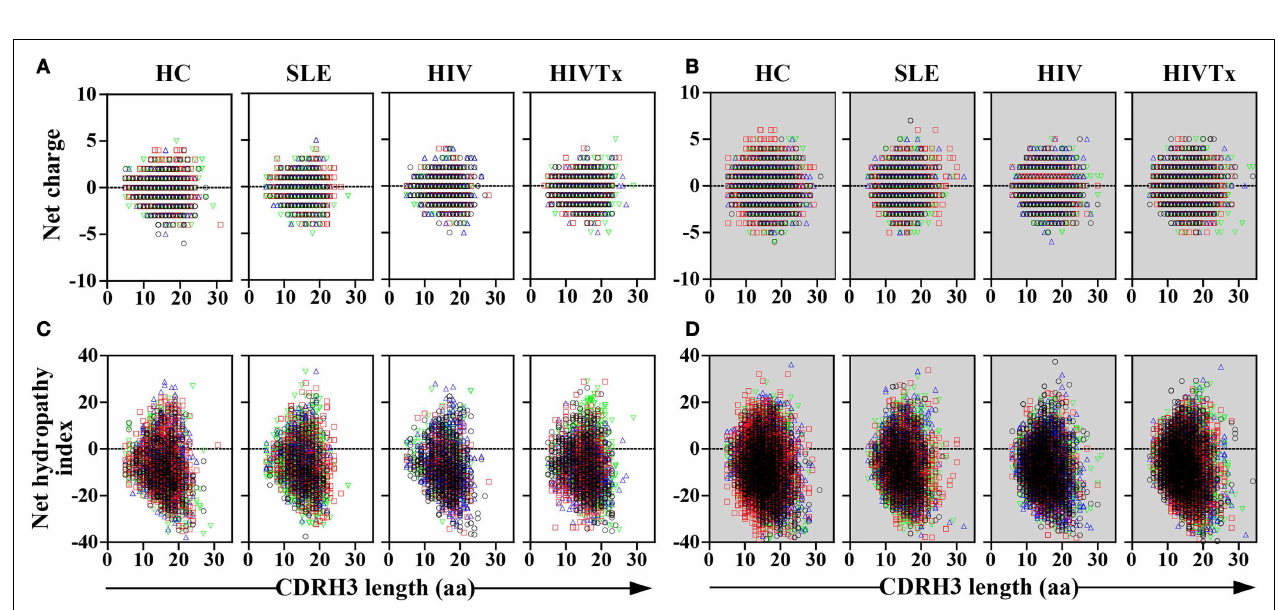
FIGURE 5 | Similar frequency of sequences with CDRH3 lengths longer than 26 amino acids among study groups . (A) Among SHM − sequences, frequency of sequences with greater than 26 amino acids CDR3 length ranged from 0.03 [ ± 0.06%] to 0.13% [ ± 0.12%], which was similar among